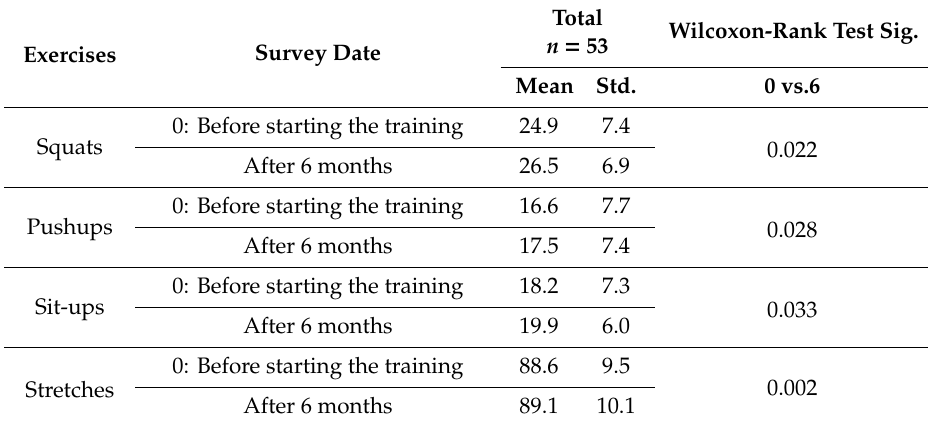
Table 2. Parameters describing fitness at months 0 and 6.